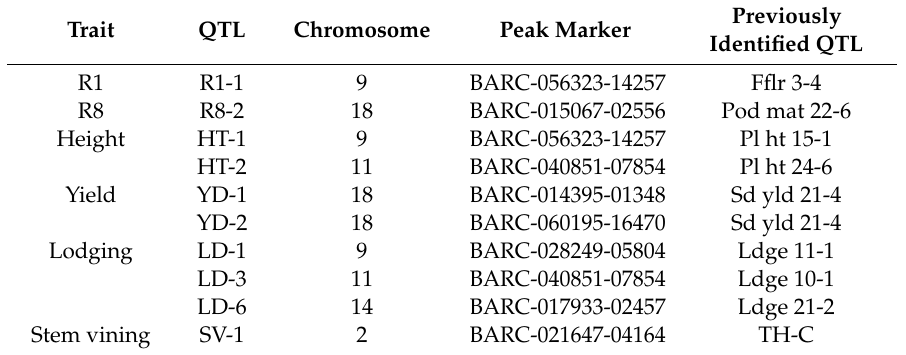
Table 3. Previously reported QTL (http: // soybase.org / ) that overlap with the QTL identified in this study.